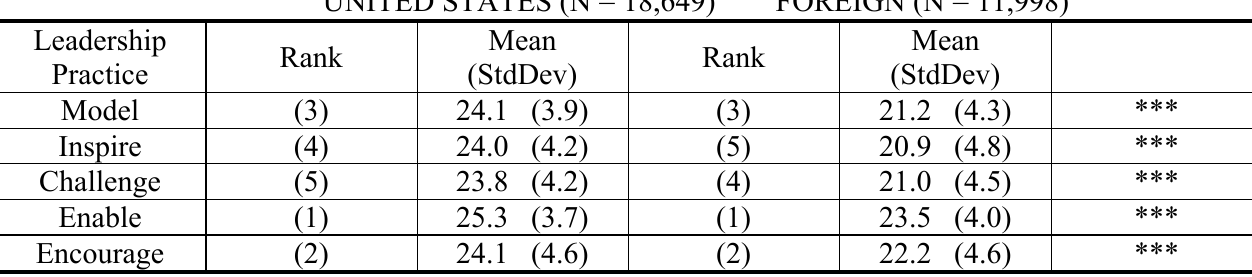
Table 5b. Comparisons between Respondents in the United States and Outside the United States [Foreign] (Observers).